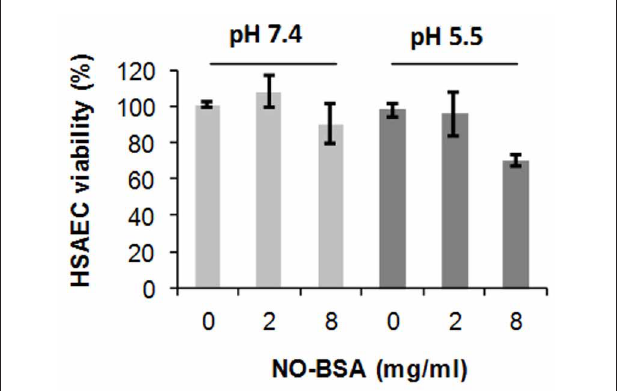
FIGURE 9 | Nitrosylated BSA (NO-BSA) is not acutely toxic. HSAECS were incubated with NO-BSA at indicated concentrations and pH for 2h in